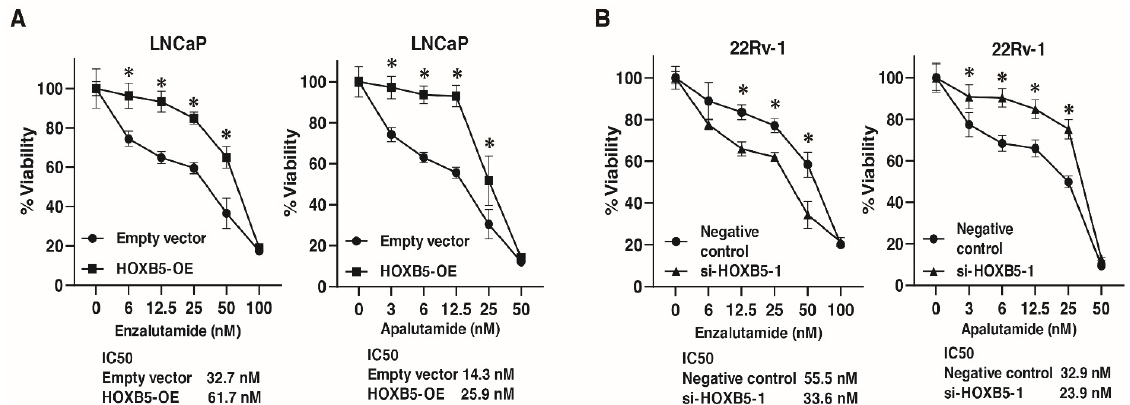
Figure 7. HOXB5 is involved in enzalutamide and apalutamide resistance in PCa. ( A ) The dose-dependent effects of enzalutamide and apalutamide on the viability of LNCaP cells transfected with HOXB5 expressing vector (HOXB-OE) and empty vector. * p < 0.05. IC50 values are indicated. ( B ) The dose-dependent effects of enzalutamide and apalutamide on the viability of 22Rv-1 cells transfected with negative control siRNAs and HOXB5 siRNA (si-HOXB5-1). * p < 0.05. IC50 values are indicated.